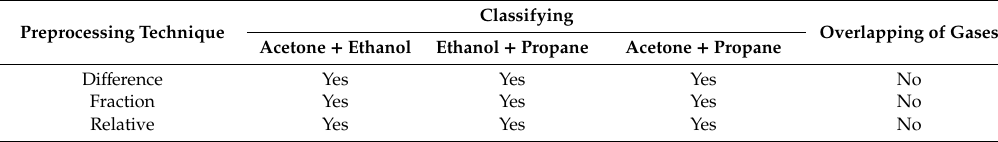
Table 3. Summary of classification